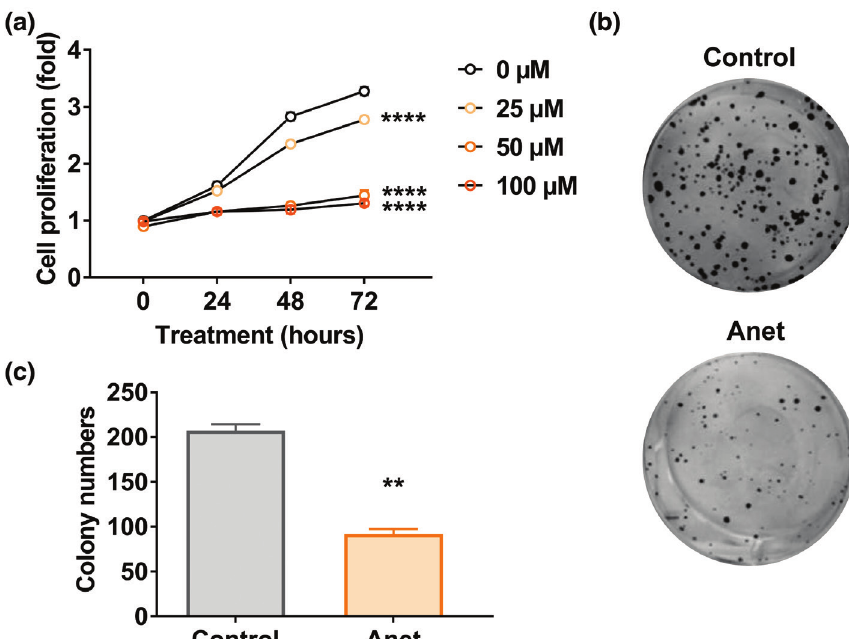
Fig. 1. Anethole inhibited the proliferation of A549 cells. (a) A549 cells were treated with anethole at the indicated concentra- tions for the indicated times, and cell proliferation was determined by MTT assay. (b and c) Colony formation assay of A549 cells under the treatment of vehicle or 50 μM anethole was conducted to examine the effect of anethole on the proliferation of A549 cells. Four replicated wells for each condition. Error bar represents SEM. ** P < 0.01 and **** P <